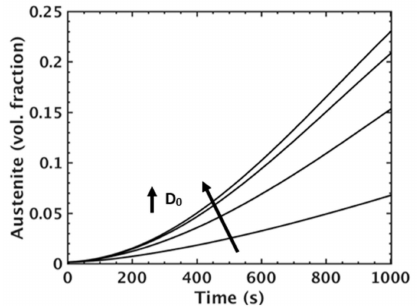
Figure 9. MICRESS ® simulation results for austenite volume fraction during intercritical annealing for simulations incorporating di ff erent Mn di ff usivity pre-factors for Mn di ff usivity in ferrite ( D 0 ).